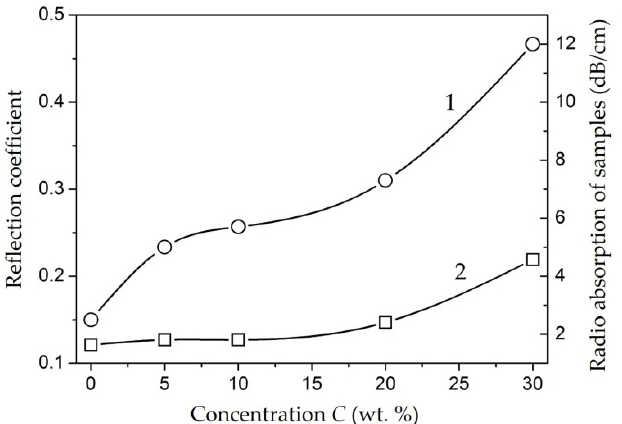
Figure 35. Dependence of specific radio absorption (1) and reflection coefficient (2) on concentration of nickel ferrite nanoparticles [151].